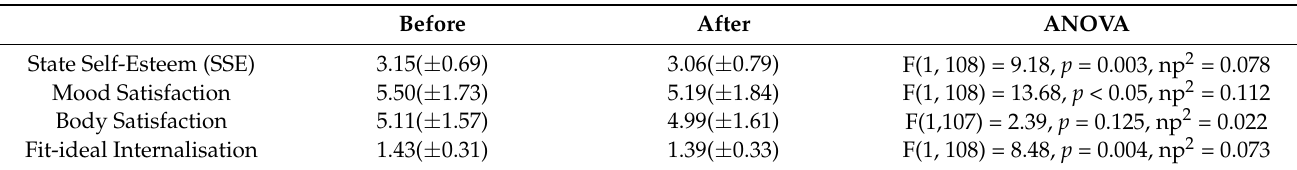
Table 1. Means and Standard Deviation values for SSE, mood satisfaction, body satisfaction and fit-ideal internalisation, before and after fitspiration exposure.